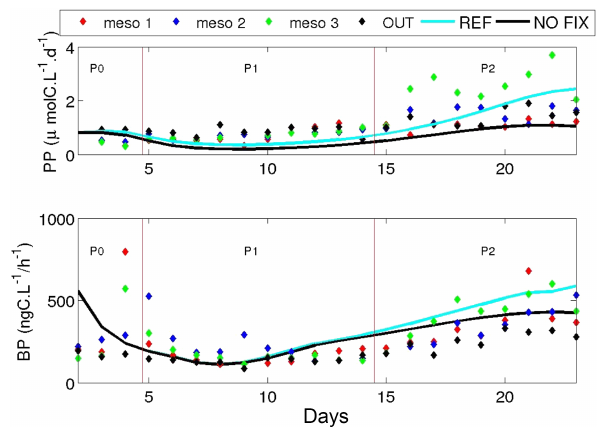
Figure 6. Evolution of PP (µmolCL − 1 d − 1 ; a ) and bacterial pro- duction (ngCL − 1 h − 1 ) in the REF simulation (blue line) and the NOFIX simulation (black line; i.e. when the N 2 fixation process is